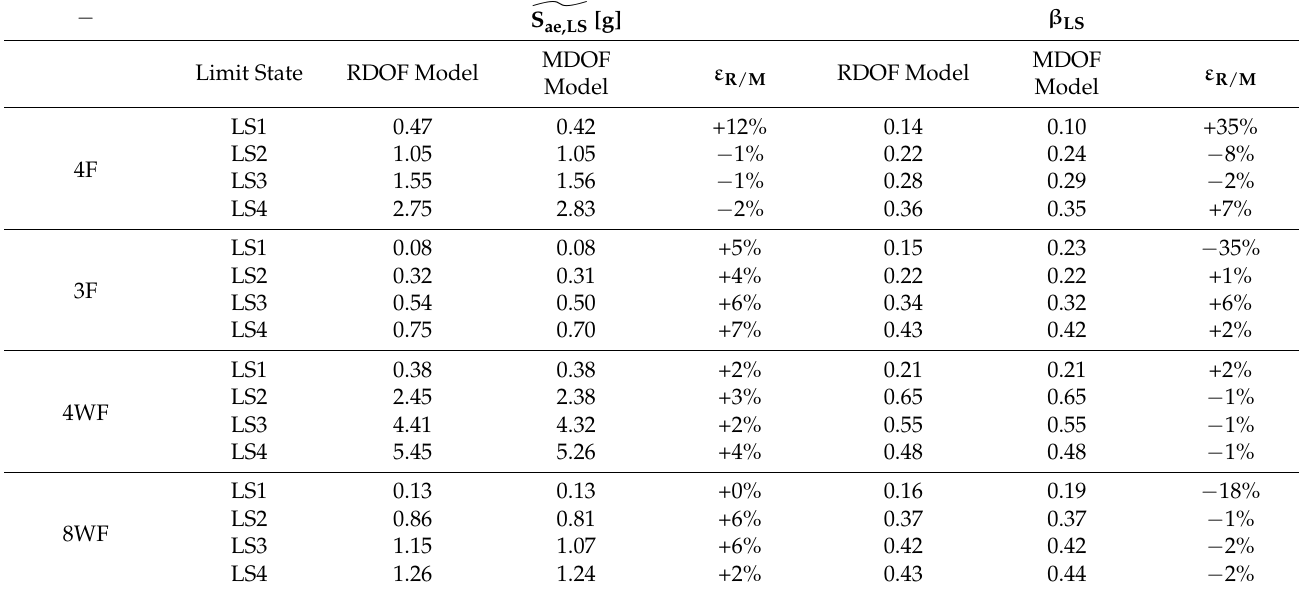
Table 2. The limit-state spectral accelerations at the fundamental buildings’ periods deviation of limit-state spectral accelerations in logarithmic values β LS , and the corresponding error ε R/M for measuring the difference between the results based on the RDOF and MDOF models of 4F, 3F, 4WF, and 8WF buildings. If the (cid:94) limit-state S ae,LS of the RDOF and MDOF model are equal, the nonzero error is the consequence of rounding decimals of the considered